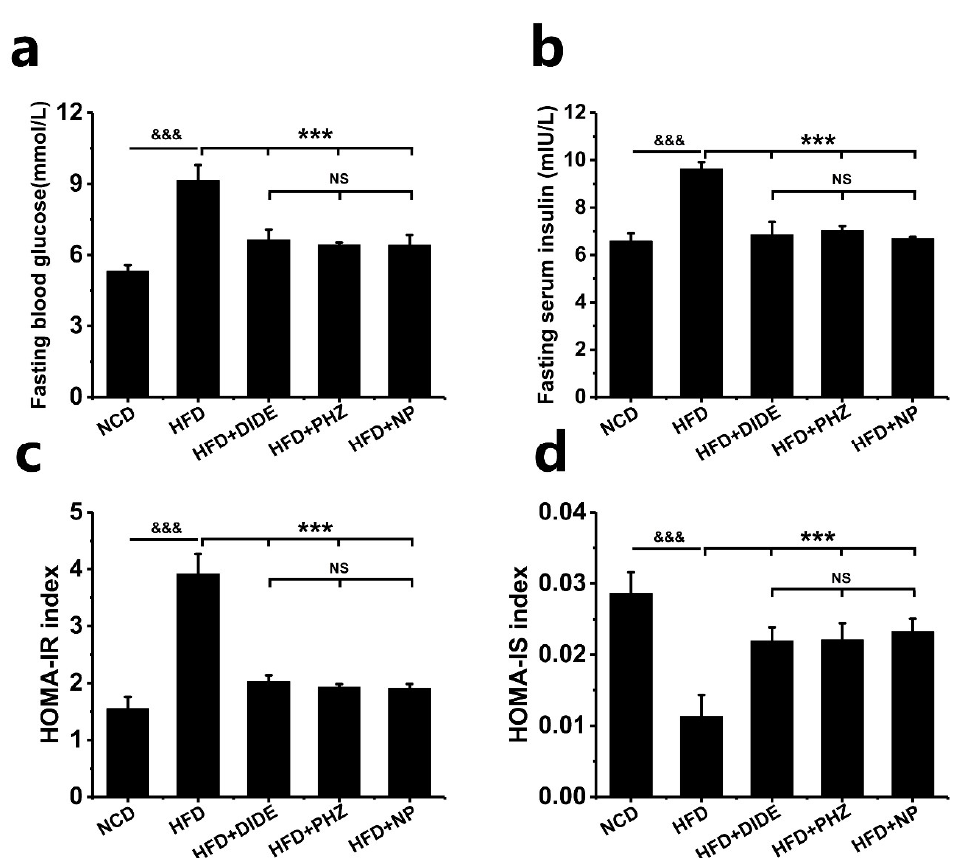
Figure 4. Effects of DIDE, PHZ and NP administration on plasma glycemia markers (n = 10 per group). ( a ) Fasting blood glucose. ( b ) Fasting Serum insulin. ( c ) HOMA-IR index. ( d ) HOMA-IS index. Data are Mean ± SEM. Significant differences between HFD vs. ND are indicated: & p < 0.05; && p < 0.01; &&& p < 0.001. Significant differences between DIDE, PHZ and NP vs. HFD are indicated: * p < 0.05; ** p < 0.01; *** p < 0.001. NS indicates no significant difference between the two groups.